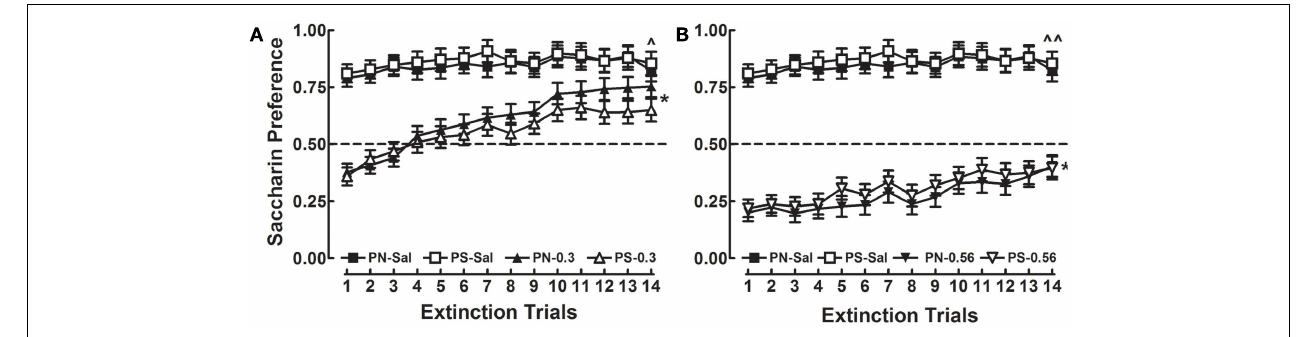
were no significant effects or interactions with the factor of Prenatal Treatment or Sex. Significant differences between days 1 and 14 are indicated by * ( p < 0.001). Significant differences between SAL and the 0.3- and 0.56-mg/kg METH groups are indicated by ∧ ( p < 0.05) and ∧∧ ( p <